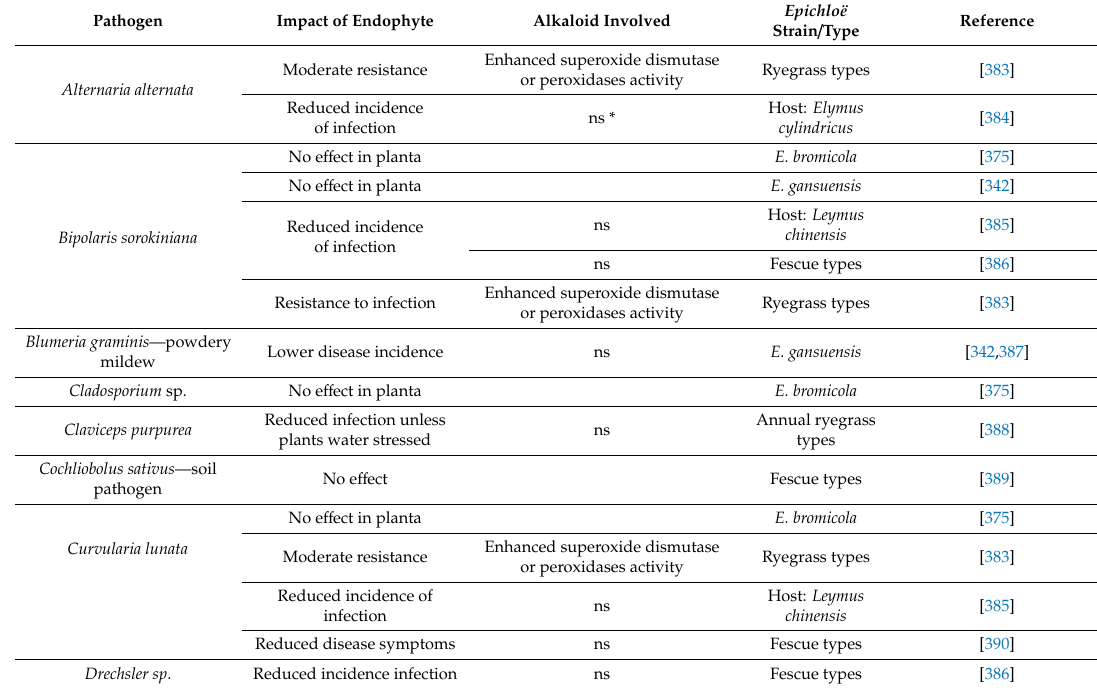
Table 5. Pathogens impacted by Epichloë endophytes in